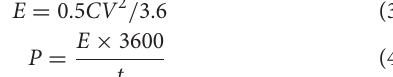
Frontiers in Chemistry |